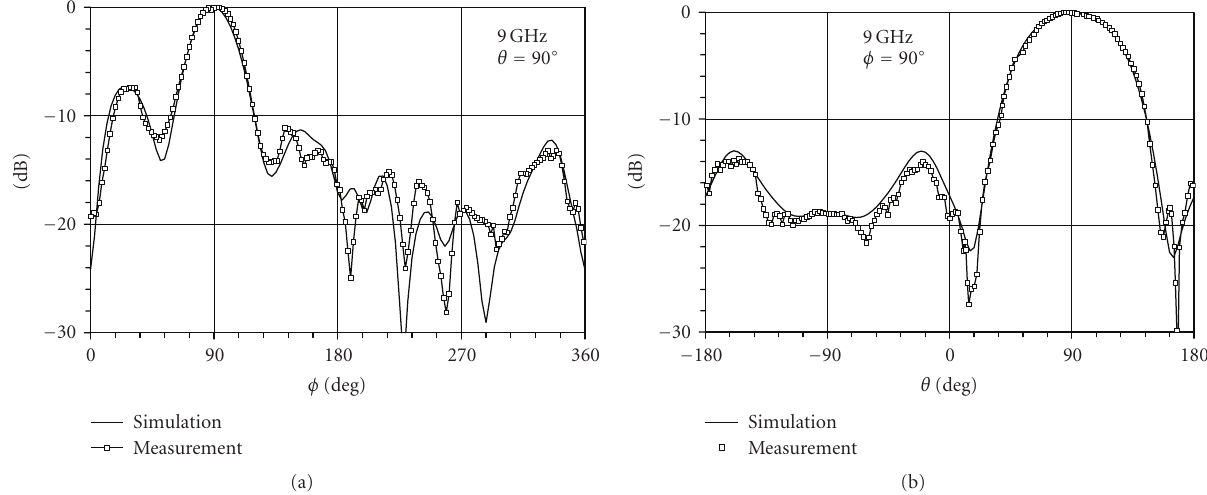
Figure 3: Comparison of simulated and measured radiation patterns of the reference DETASA shown in Figure 1; (a) E-plane, (b) H-plane.